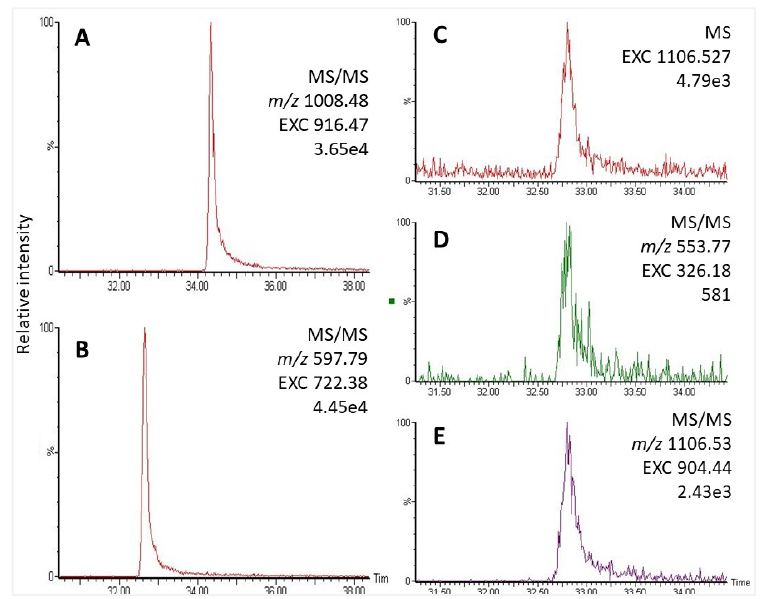
Figure 6. Chromatograms for signals in the methanolic CC extract from the corn borer O. nubilalis assigned to ( A ) Manse-AKH (EXC b 7~ ), ( B ) Vanca-AKH (EXC y 7 ), ( C – E ) Ostnu-AKH: ( C ) MS of the parent ion; ( D ) MS/MS doubly-charged ion, EXC b 2 ; ( E ) MS/MS singly-charged ion, EXC b 7